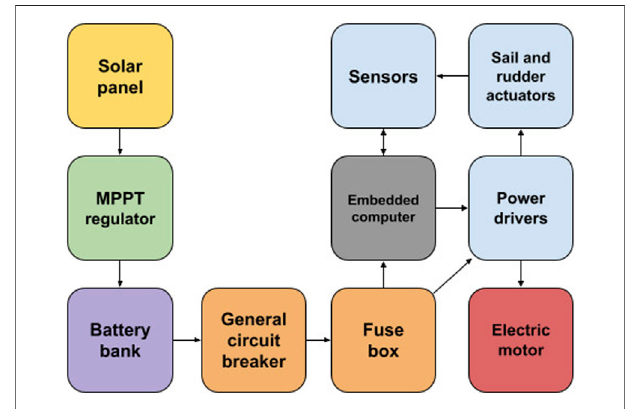
FIGURE 7 | Current × Voltage curve for a photovoltaic panel.